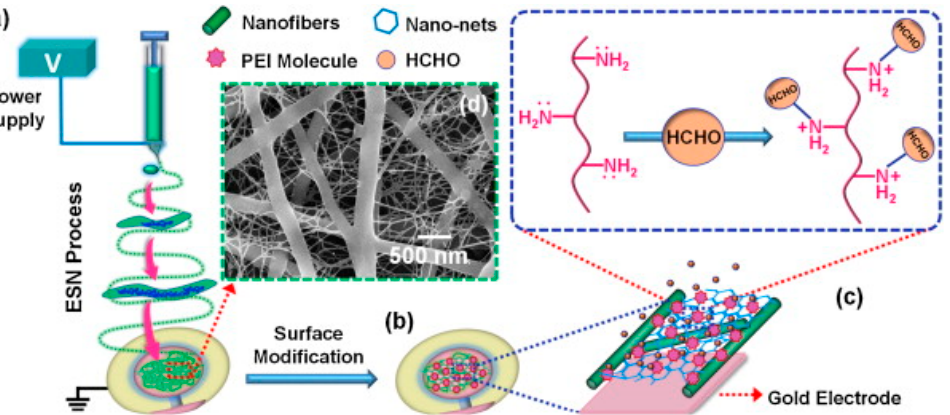
Figure 8. Schematic diagram illustrating the fabrication of sensing layers on QCM. ( a ) ESN deposition of fibrous membranes onto the electrode of QCM. ( b ) Surface modification of NNB with diluted PEI solutions. ( c ) Illustration of PEI-chitosan fibers on the gold electrode and the reaction mechanism between formaldehyde and PEI. ( d ) Typical FE-SEM image of NNB structured chitosan membranes [111] . (Copyright (2014) ELSEVIER).